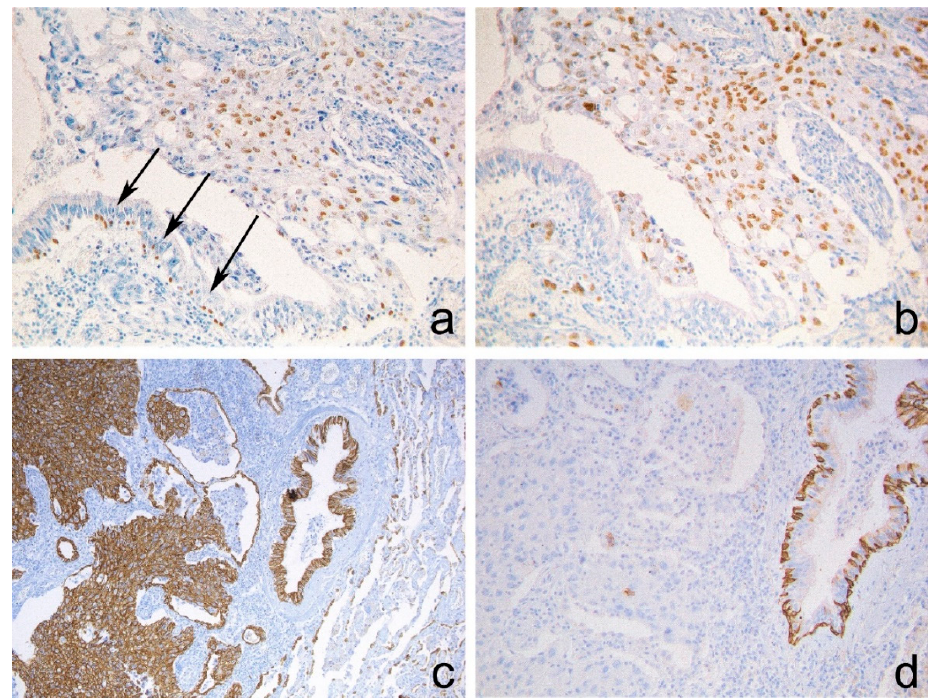
Figure 2. Positive immunostaining for ( a ) p63, ( b ) TTF-1 and ( c ) CK7 and negative immunostaining for ( d ) CK5/6 in neoplastic infiltrating areas. p63 and CK5/6 stained positively the basal layer of the terminal bronchiolar epithelium ( a , arrows; d , right side). ( a – d ) Immunoperoxidase stain. Original magnification: ( a , b , d ) 200×; ( c ) 100×.